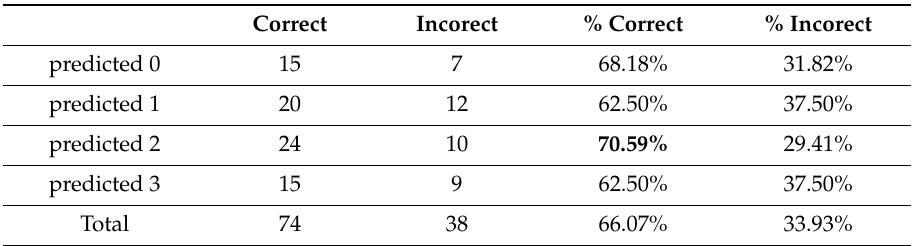
Table 6. Comparison of predicted to real rating